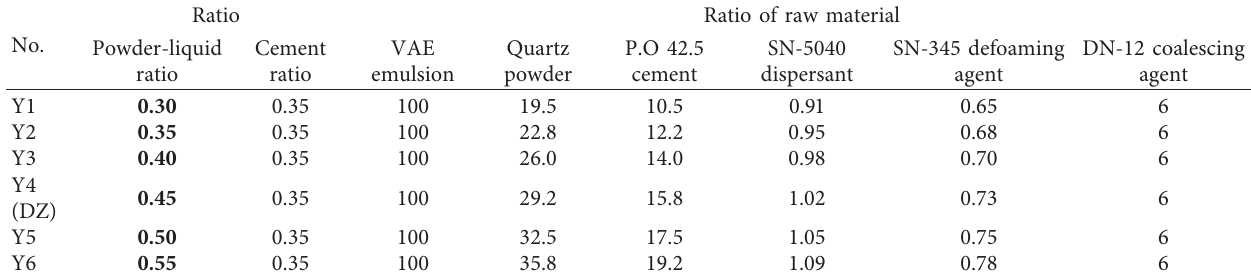
Table 2: Ratios with powder-liquid ratio as the variable.